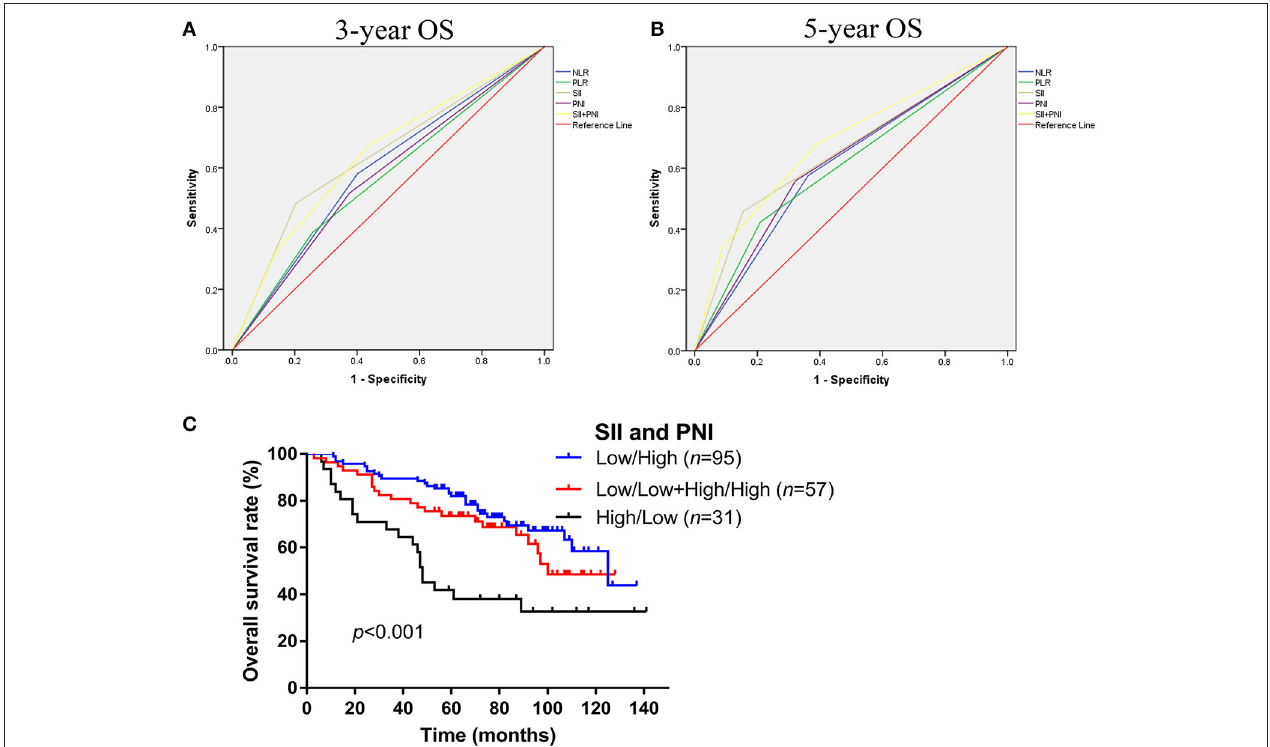
FIGURE 3 | Comparison the predictive values of NLR, PLR, SII, PNI, and SII + PNI for OS in skull base chordoma. (A) ROC curves of NLR, PLR, SII, PNI, and SII + PNI for 3-year OS. (B) ROC curves of NLR, PLR, SII, PNI, and SII + PNI for 5-year OS. (C) Kaplan–Meier survival curves indicated patients with high SII and low PNI had